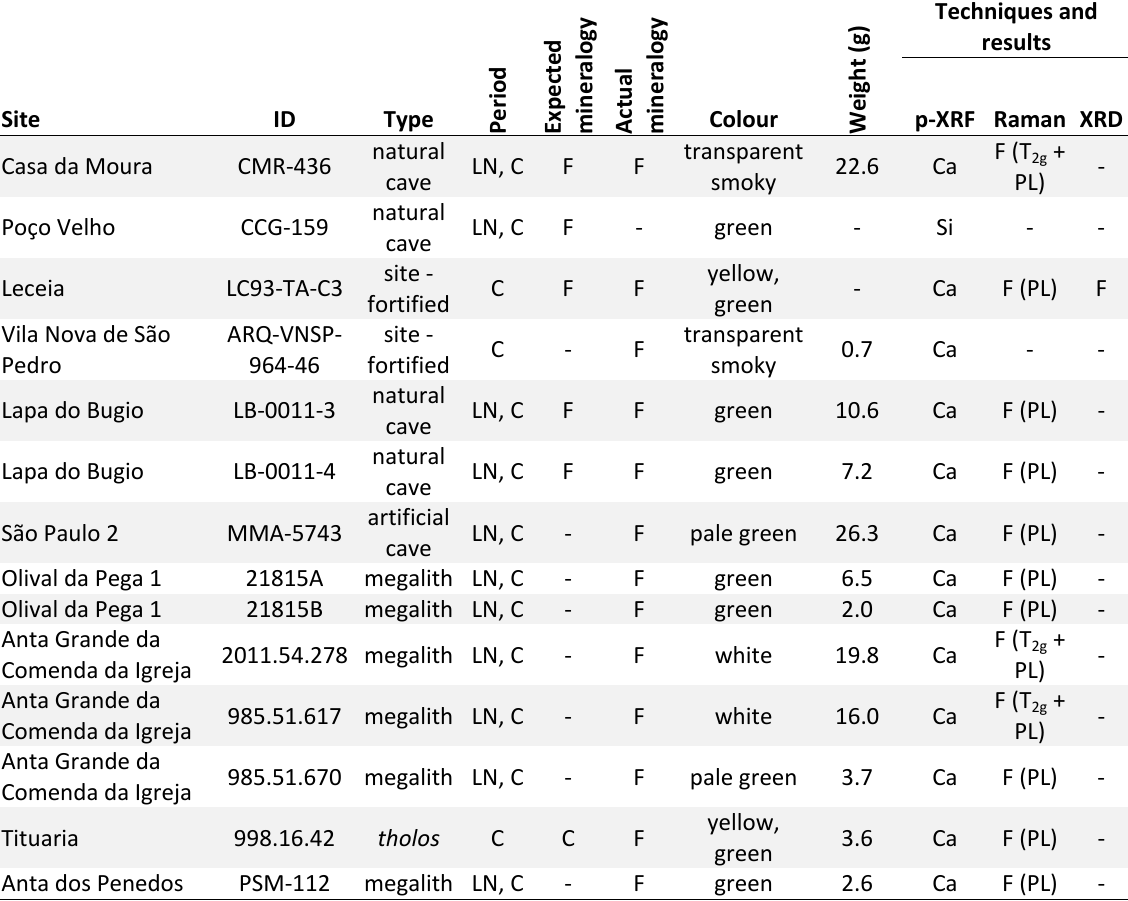
Table 1. Inventory of fluorite items in Iberian late prehistory. Period legend: LN, Late Neolithic; C, Copper Age; B, Bronze Age. Mineralogy legend: F: fluorite; C: calcite; Q: quartz; Ame: amethyst; Ca: Calcium; Si: Silicon; PL: Photoluminiscence.